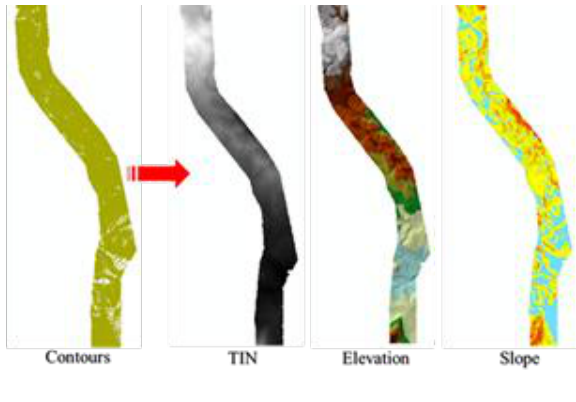
Figure6. Derived Raster